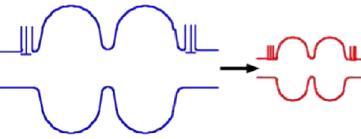
FIG. 9. (Color) Definition of off-axis parameter x .FIG. 8. (Color) Linear cavity